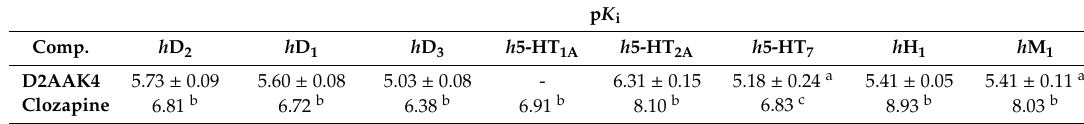
Table 1. Experimental radioligand binding data for D2AAK4. Data are expressed as p K i (mean ± SEM) of two (or three for 5-HT 2A ) independent experiments performed in duplicate. a Full displacement of specific binding was not achieved at the maximum concentration assayed, so p K i value could be not accurately estimated; maximum displacement achieved (at 100 µ M) was 88% (5-HT 7 ) and 91% (M 1 ). Clozapine reference a ffi nity values at the indicated targets are shown for comparison. b Data taken from PDSP Ki database (https: // pdsp.unc.edu / databases / kidb.php). c Data taken from [32]. p K i Comp. h D